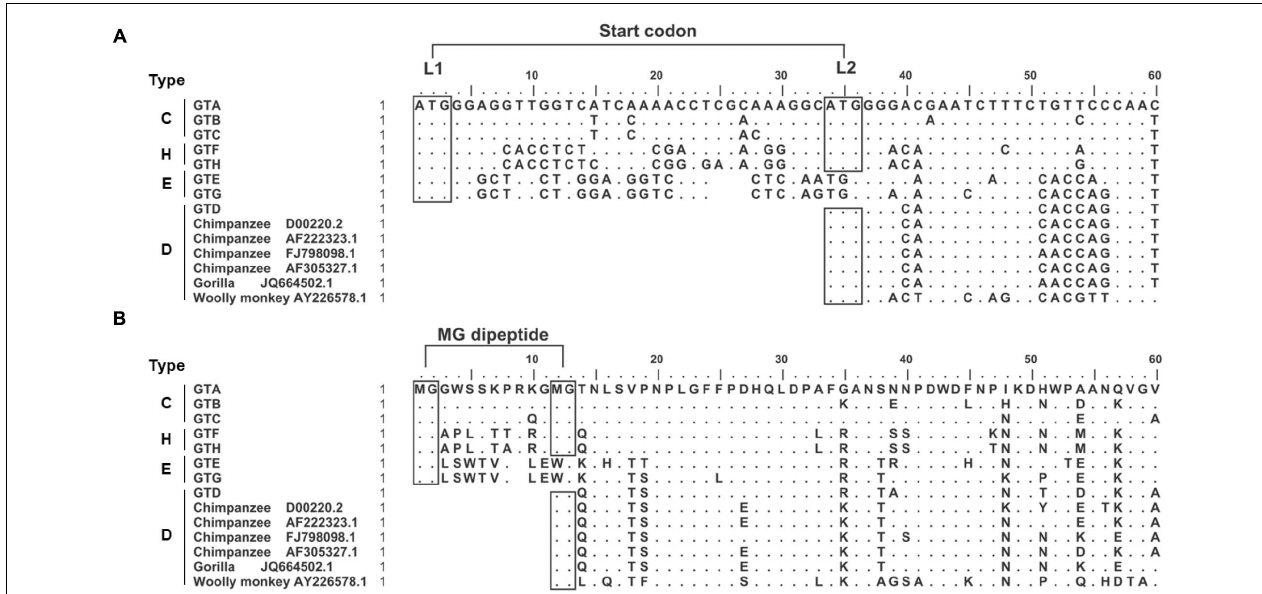
FIGURE 1 | Genotype dependent heterogeneity of HBV preS1 N-terminal sequences from primate hepadnaviruses. (A) Alignment of 5 (cid:48) preS1 nucleotide sequences. The GTA-GTH sequences are consensuses from alignments in HBVdb database. The numbering and sequence alignment are based on GTA. Dot means homologous to GTA, while space indicates deletion. The boxes with “ATG” indicate (potential) start codon, which is named as L1 and L2, respectively. (B) Alignment of preS1 N-terminal aa sequences. The boxes with “MG” indicate (potential) myristoylation motif. The preS1 N-terminal sequences were divided into four types. C-type represents preS1 (aa 1–14) in GTA-GTC; H-type represents preS1 (aa 1–14) in GTF and GTH; E-type represents preS1 (aa 1–13) in GTE and GTG; D-type represents preS1 (aa 1–3) in GTD and hepadnaviruses from non-human primates. aa, amino acid; GT, genotype; nt, nucleotide.